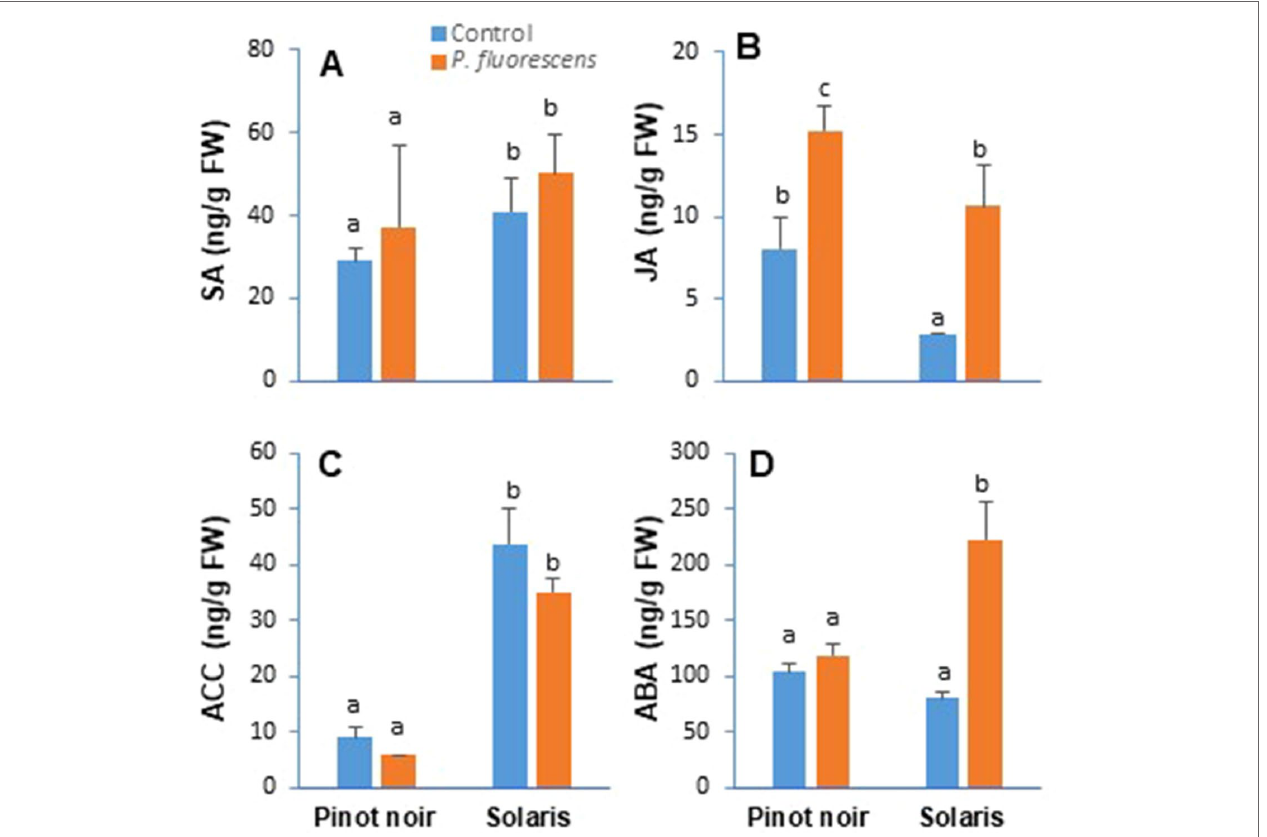
FIGURE 2 | Pseudomonas fluorescens PTA-CT2 induces differential production of phytohormones in the leaves of grapevine cultivars Pinot noir and Solaris. Plants were treated at the root level with P. fluorescens at 10 7 CFU g −1 of soil, and 2 weeks later, the amounts of salicylic acid (A) , jasmonic acid (B) , 1-aminocyclopropane- 1-carboxylic acid (C) , and abscisic acid (D) were quantified by liquid chromatography (LC)–tandem mass spectrometry (MS/MS). Data are the means from three independent experiments performed in 2017, and vertical bars indicate standard deviation. Different letters indicate statistically significant differences between the treatments (ANOVA Tukey test, P <